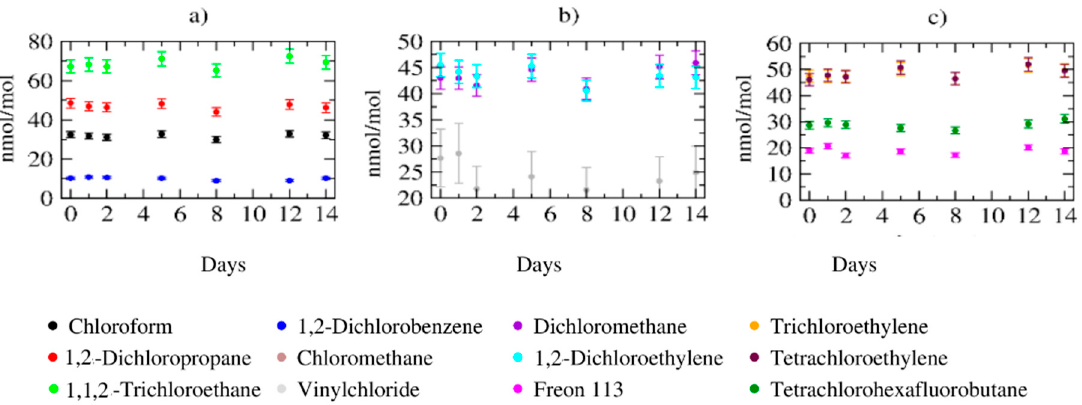
Figure 6. Storage stability of halogenated hydrocarbons on Tenax TA. ( a ) for 1,2-dichlorobenzene, 1,2-dichloropropane, 1,1,2-trichloroethane, chloroform; ( b ) for 1,2-dichloroethylene, vinylchloride, for chloromethane, dichloromethane. ( c ) for tetrachlorohexabutane, trichloroethylene, tetrachloroethylene, freon 113.